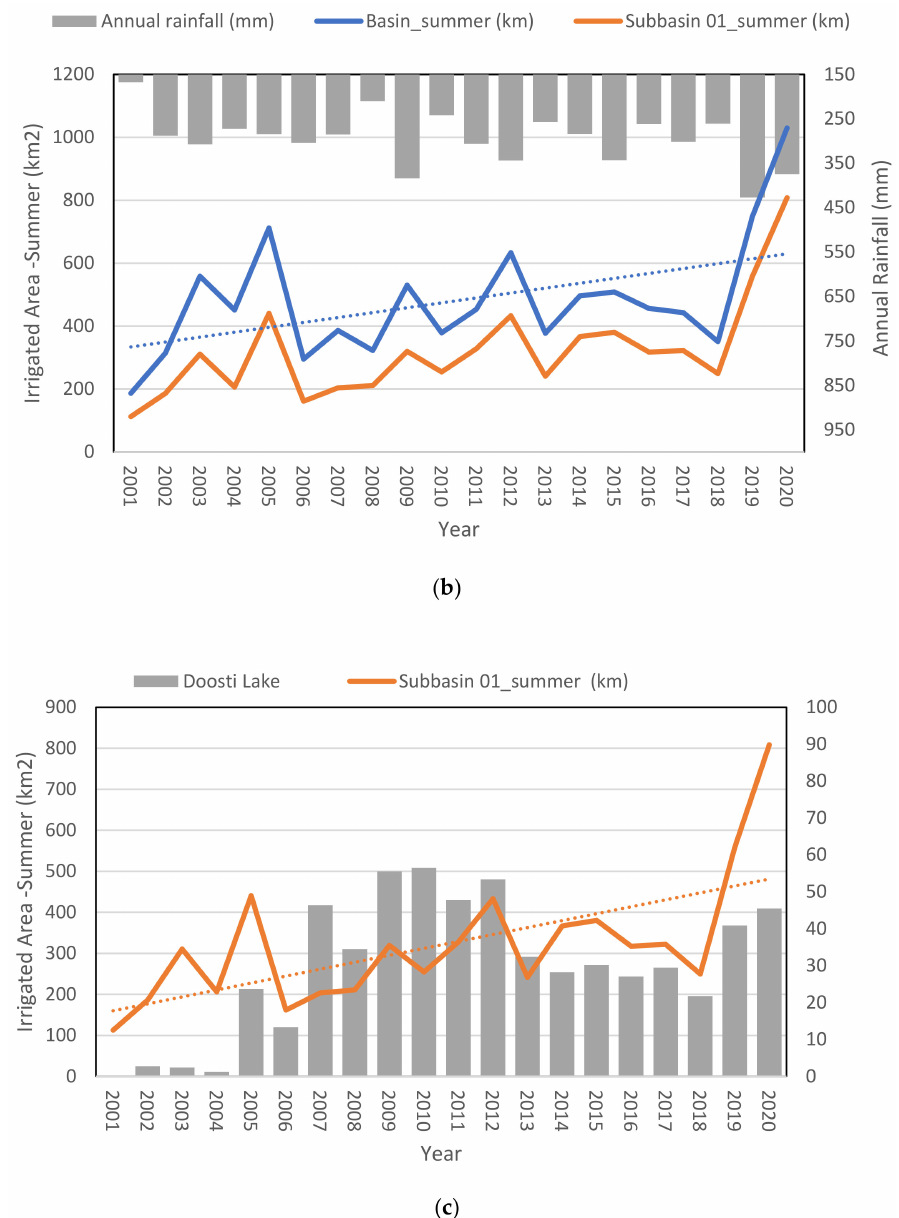
Figure 13. ( a ) Spatial distribution of irrigated cultivated lands in Doosti Dam’s basin as well as changes that occurred between 2001 and 2020, ( b ) correlation between rainfall (CHIRPS), irrigated cultivated areas of basin (km 2 ) in summer growing season based on the MODIS NDVI (MOD09Q) product derived from GEE during 2001–2020 ( c ) Correlation between rainfall time series (CHIRPS), irrigated cultivated areas (km 2 ) of subbasin in summer growing season and Doosti lake based on Landsat, NDWI index product during